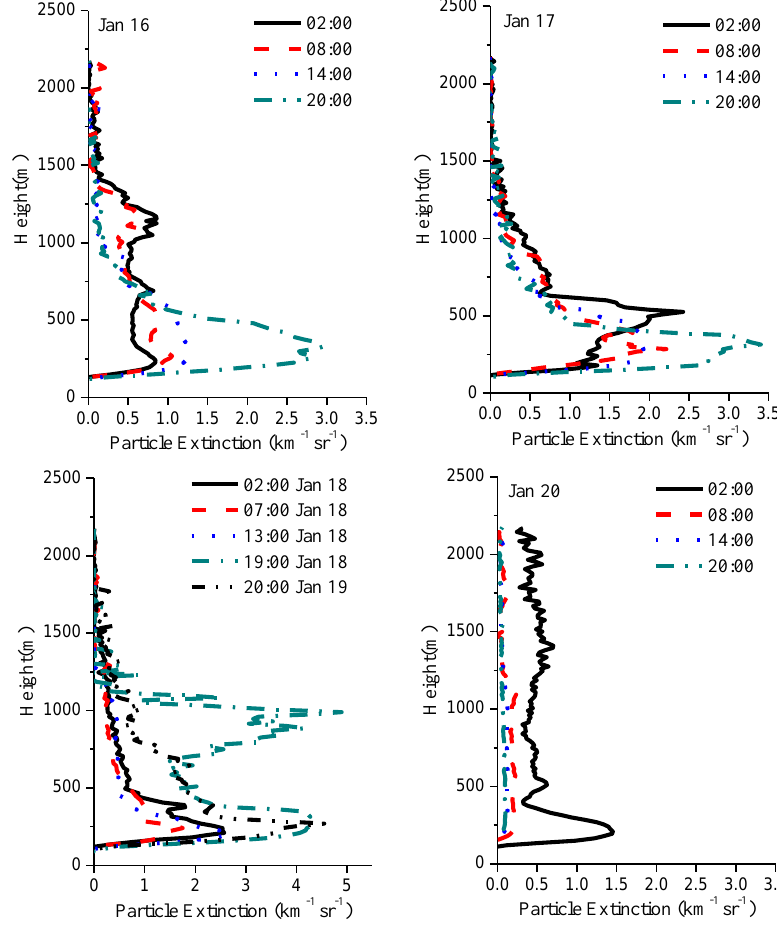
Fig. 10. Vertical profile of particle extinction at SDZ from January 16 to 20.